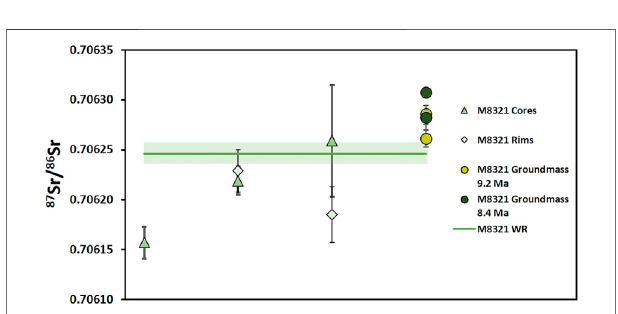
FIGURE 7 | Details of 87 Sr/ 86 Sr variation in lava sample M8321. The whole rock value from Davidson (1986) is plotted for comparison. Black and gray bars (and green box around the WR value) show uncertainty (2